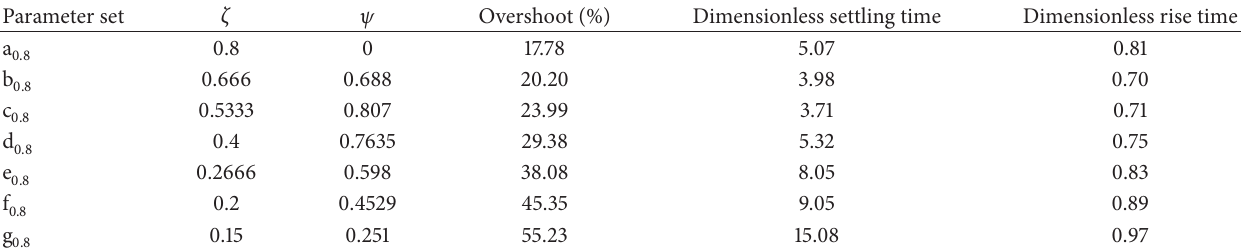
Table 3: 𝜁 - 𝜓 combinations with dimensionless settling energy equivalent to the pure PD control with 𝜁 = 0.8 . Parameter set